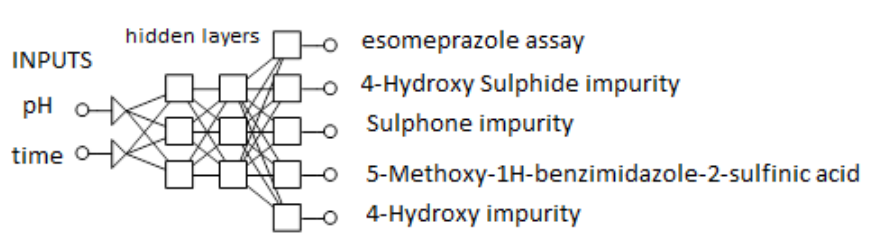
Figure 12. Four-layer MLP network architecture used.